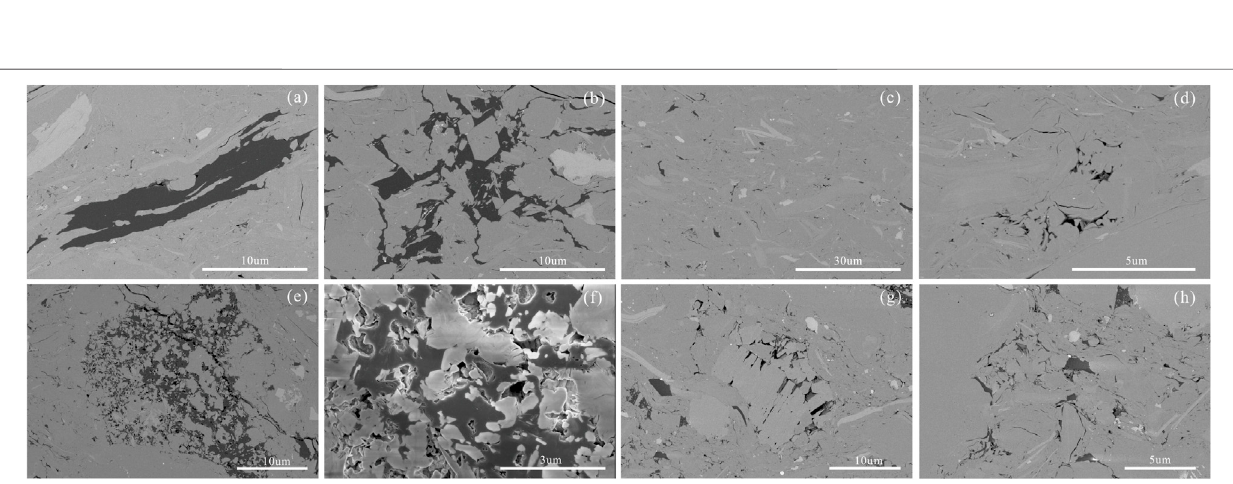
FIGURE 8 | SEM images of ORM shale samples in the Shahezi Formation. (A – D) LFS1-5; (E – H) LFS1-51. (A) Structural microfractures and organic shrinkage fractures; (B) micropores developed in the bitumen; (C) contact gaps between quartz particles and shrinkage gaps between clay minerals; (D) unevenly developed bitumen pores; (E) organic debris with little internal pores; (F) cellular pores in bitumen; (G) gaps between clay mineral layers; (H) micropores are developed in the bitumen which is fi lled between quartz.